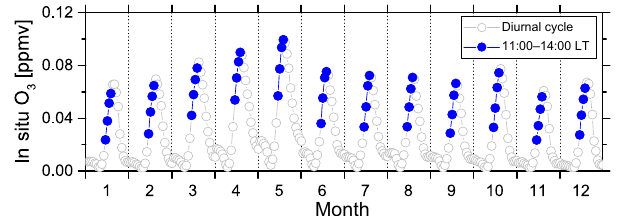
Figure 8. Seasonality of the diurnal cycles of O 3 volume mix- ing ratios measured by the three in situ monitoring stations at about 2.3kma.s.l. close to UNAM. The blue dots indicate the time frame when FTIR measurements at UNAM have been typically per-